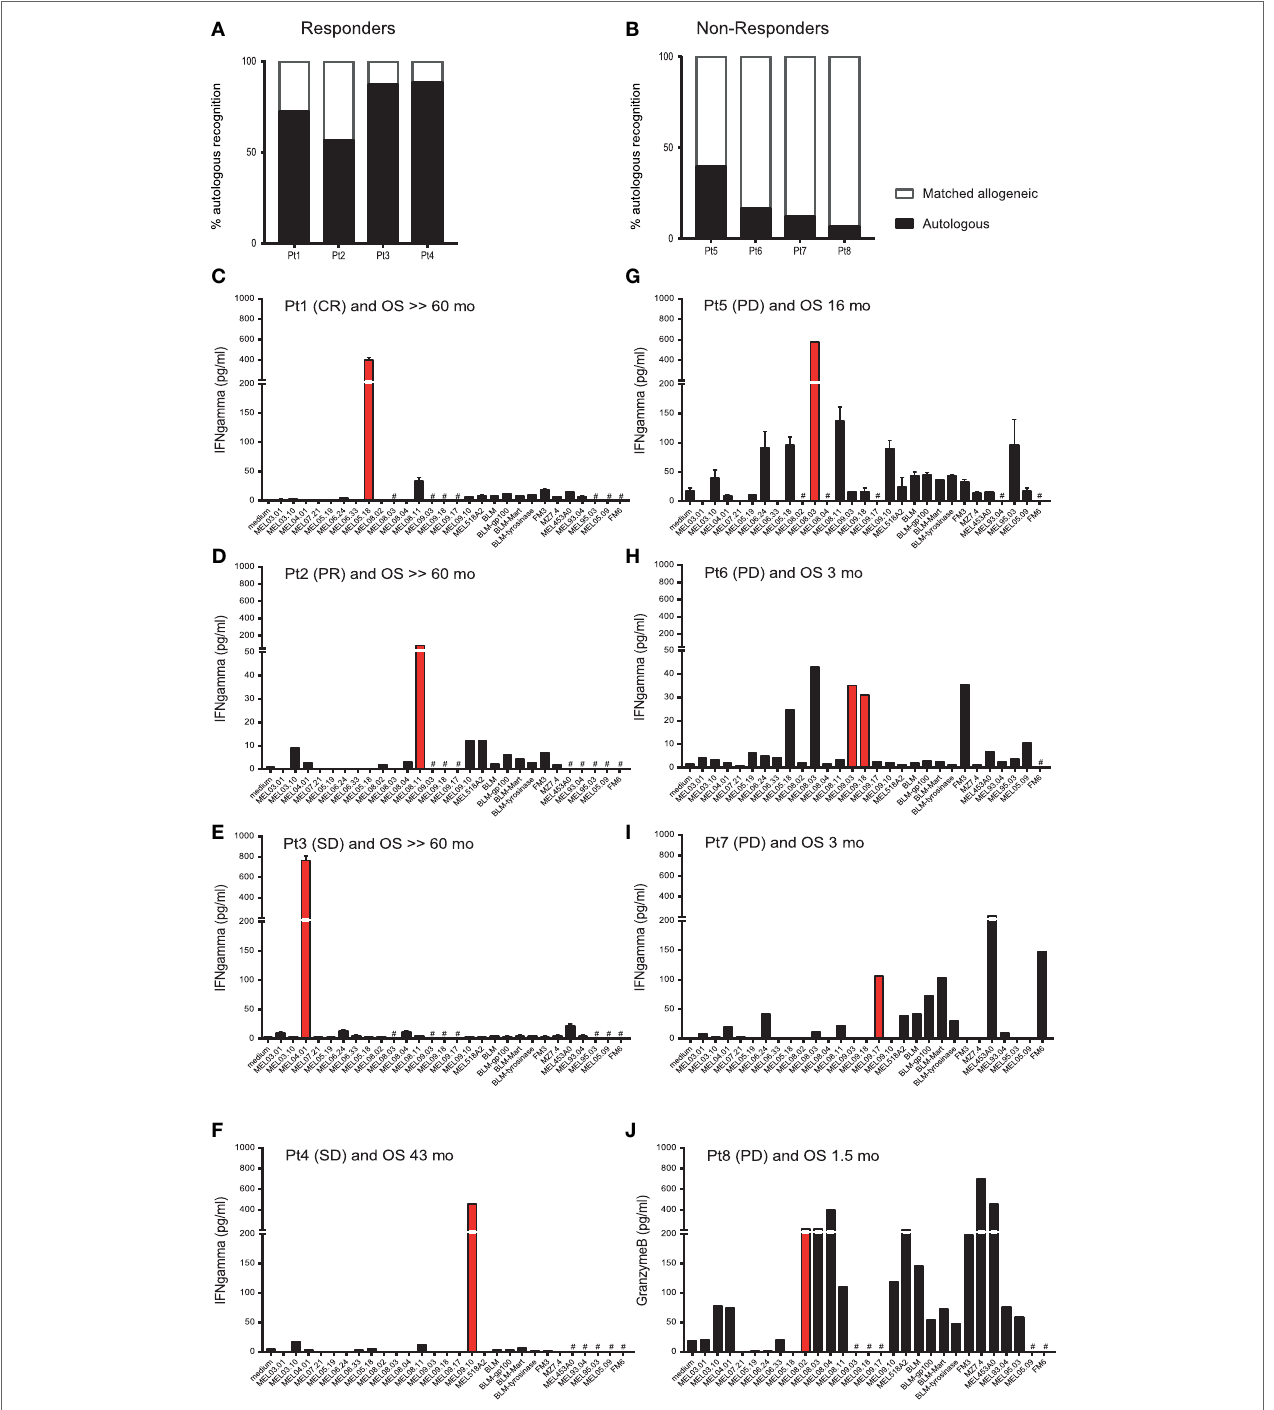
FiGUre 1 | T cell batches administered to responder patients recognize private rather than shared antigens. Tumor-reactive T cell batches were generated by repeated stimulation of PBMC with autologous melanoma cell lines in a mixed lymphocyte tumor cell culture (MLTC). These T cells were administered to melanoma patients by ACT. The patient number, with best overall response [complete response (CR), partial response (PR), stable disease (SD), or progressive disease (PD)], and overall survival (OS) in months are given. (# = not done). IFN-gamma production, as an indicator of T cell activation, was measured after incubation of T cells used for ACT with various (partially-)matched HLA class-I melanoma cell lines. The IFN-gamma production of T cells against the autologous tumor cells is depicted as a fraction of the total IFN-gamma production against all tested cells (set at 100%) for responder patients ( n = 4) and non-responder patients ( n = 4) in panels (A,B) , respectively. The data of each individual patient are given in panels (c–J) . Data in panels (c,D) were previously reported (11). IFN-gamma production upon recognition of each cell line is represented by separate bars. The red bar in each panel indicates the autologous melanoma cell line that was used to generate the corresponding T cell batch. The patients were treated in a clinical trial approved by the local ethics committee (LUMC study P04.085) and all patients gave written informed